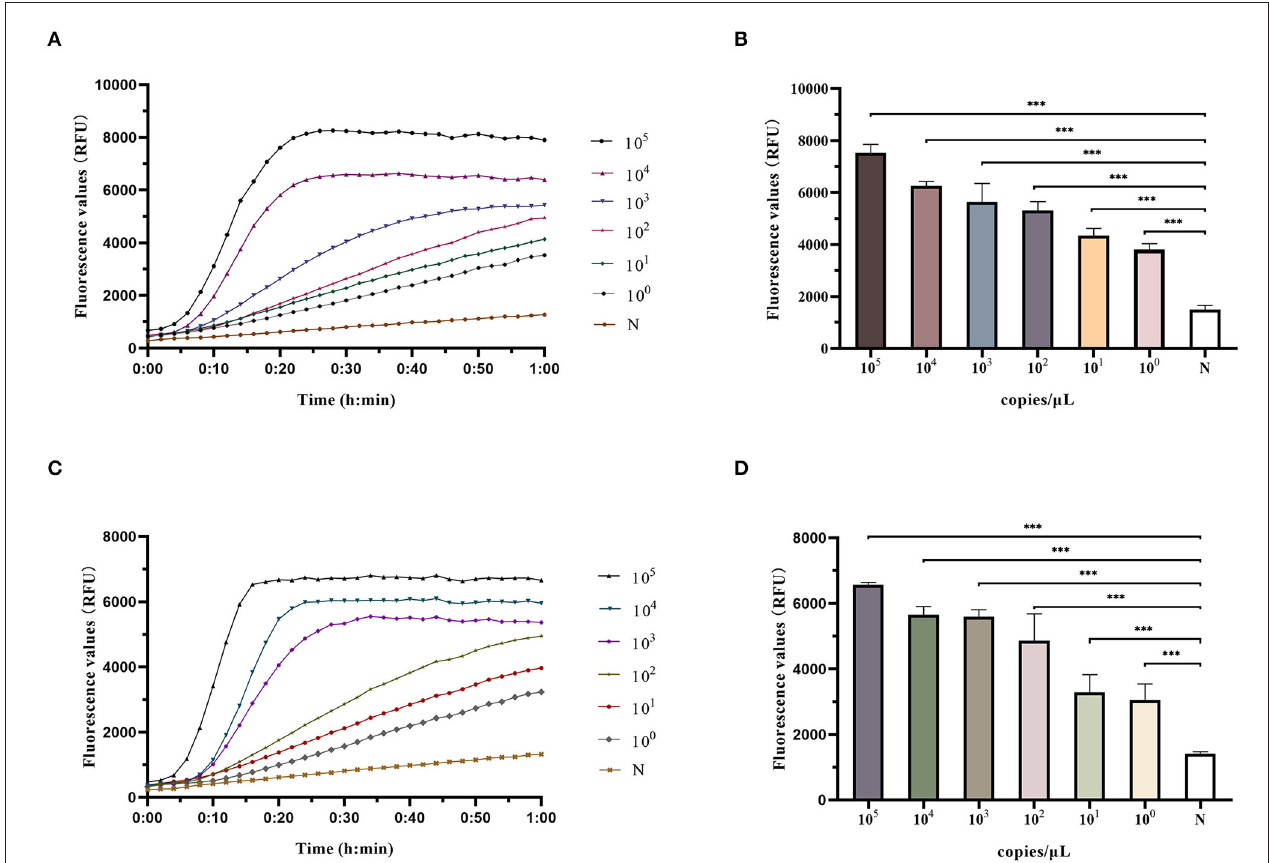
FIGURE 3 | Determination of LoD (limit of detection) of RAA-Cas12a detection system. Data were expressed as mean ± SD ( n = 3). Negative control (N) utilized RNase-free water as input instead of DNA dilutions. *** p < 0.0001. (A) Fluorescence curves were generated when Cas12a reacts with the clfA target at each dilution. (B) Comparison of fluorescence values generated after 60min of Cas12a reaction ( clfA target). (C) Fluorescence curves were generated when Cas12a reacts with the mecA target at each dilution. (D) Comparison of fluorescence values generated after 60min of Cas12a reaction ( mecA